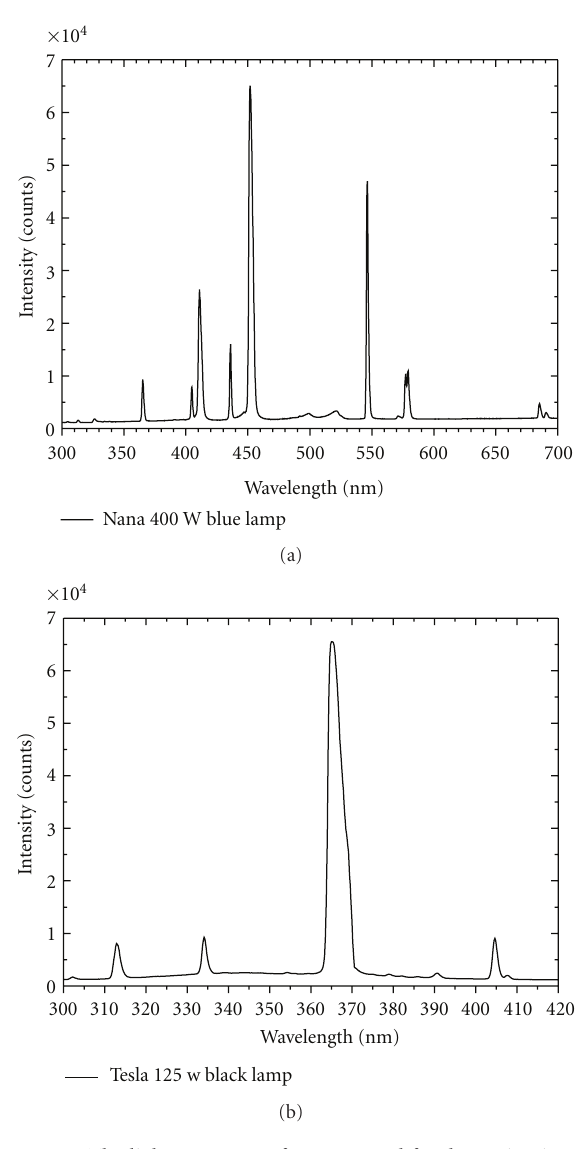
Figure 1: The light spectrum of sources used for determination of photocatalytic activity.